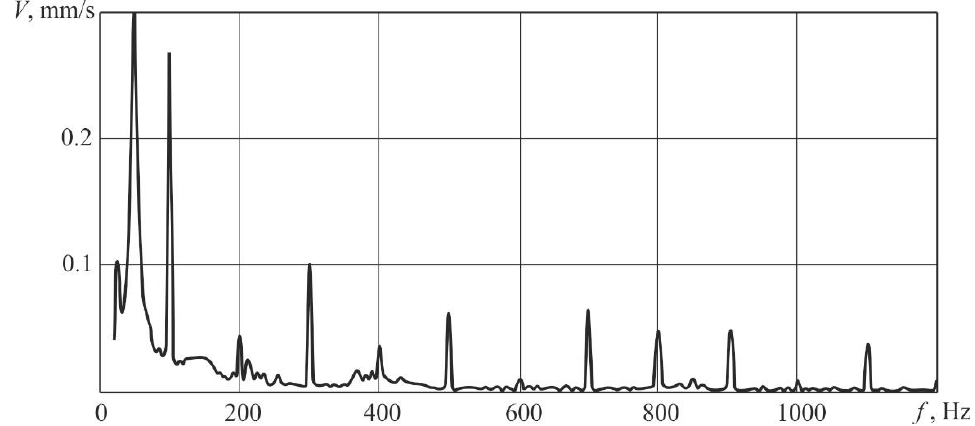
Figure 2. The spectrum of vibration rate averaged over the samples surface under laser irradiation with a pulse frequency f = 100 Hz.